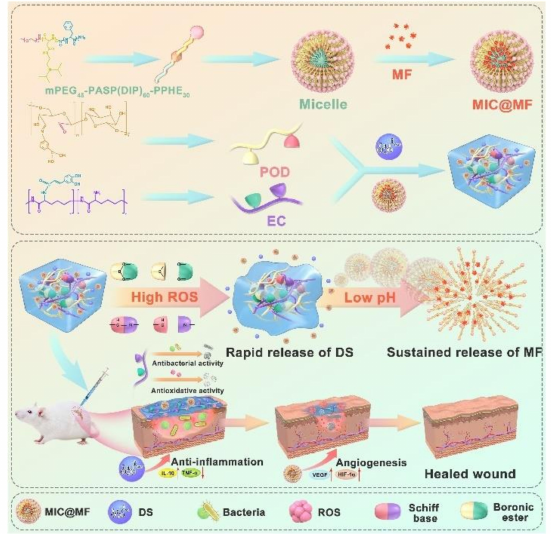
Figure 5. A spatiotemporal release platform based on pH/ROS stimuli-responsive hydrogel in wound repairing: The fabrication procedures of the DS&MIC@MF embedded POD/CE hydrogels, illustration of spatiotemporally drugs release behavior of the hydrogel, and the mechanism of the hydrogel for accelerating wound healing on the infected diabetic cutaneous wound model